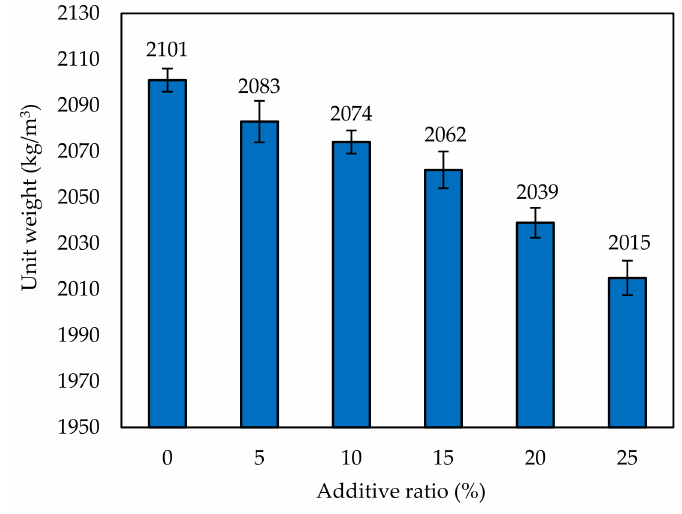
Figure 7. The unit weight test results of the cementitious composites.